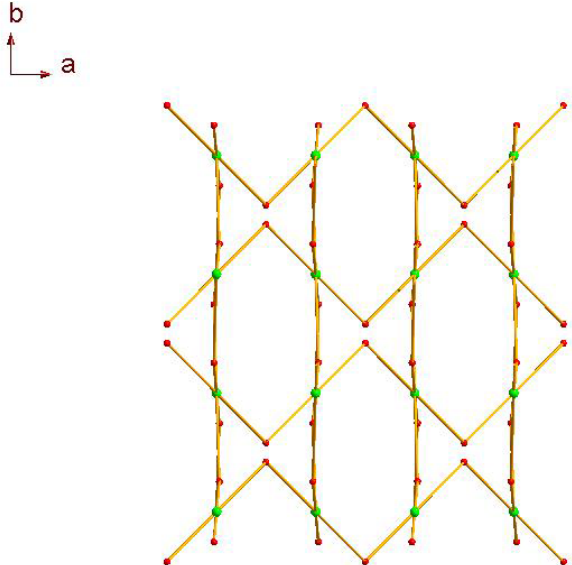
Figure 6. View of the 3-D coordination topology network created by the coordination layer and the L ligand.